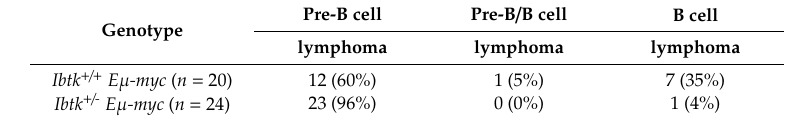
Table 1. Immunophenotype of lymphomas developed by Ibtk +/+ E µ -myc and Ibtk +/ - E µ -myc mice. Pre-B cell Pre-B / B cell B cell Genotype lymphoma